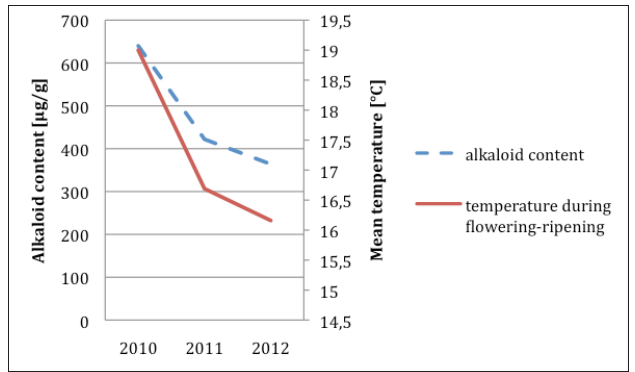
Fig. 2: Relationship between mean alkaloid content of eleven lupin geno- types cultivated under organic conditions and mean temperature from flowering to pod ripening (Pearson correlation coefficient R = 0.9997, p = ≤ 0.05).